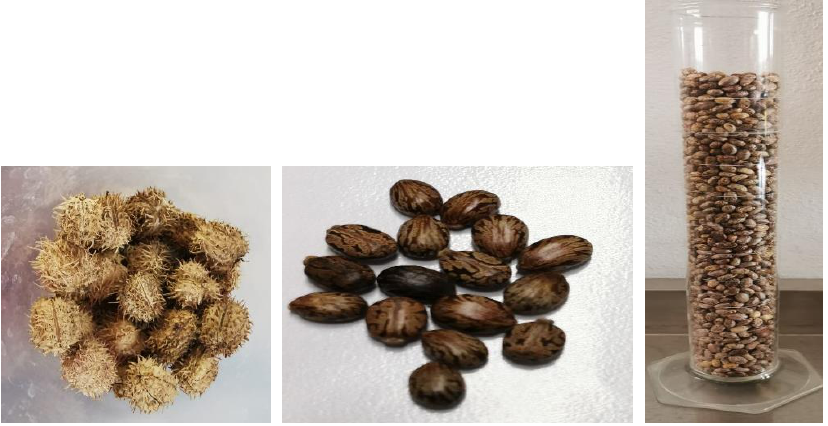
Figure 1. Bunches, seeds, and weight of 1000 seeds of Ricinus communis plants.